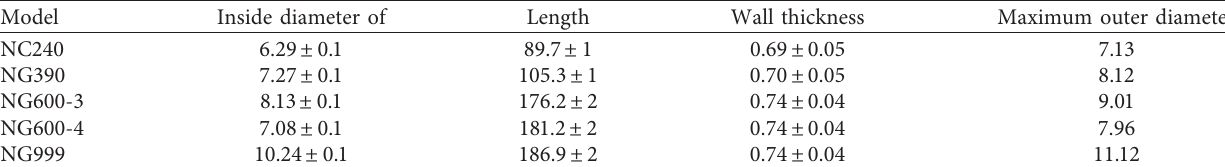
Table 2: Dimensions of some alumina ceramic tubes.